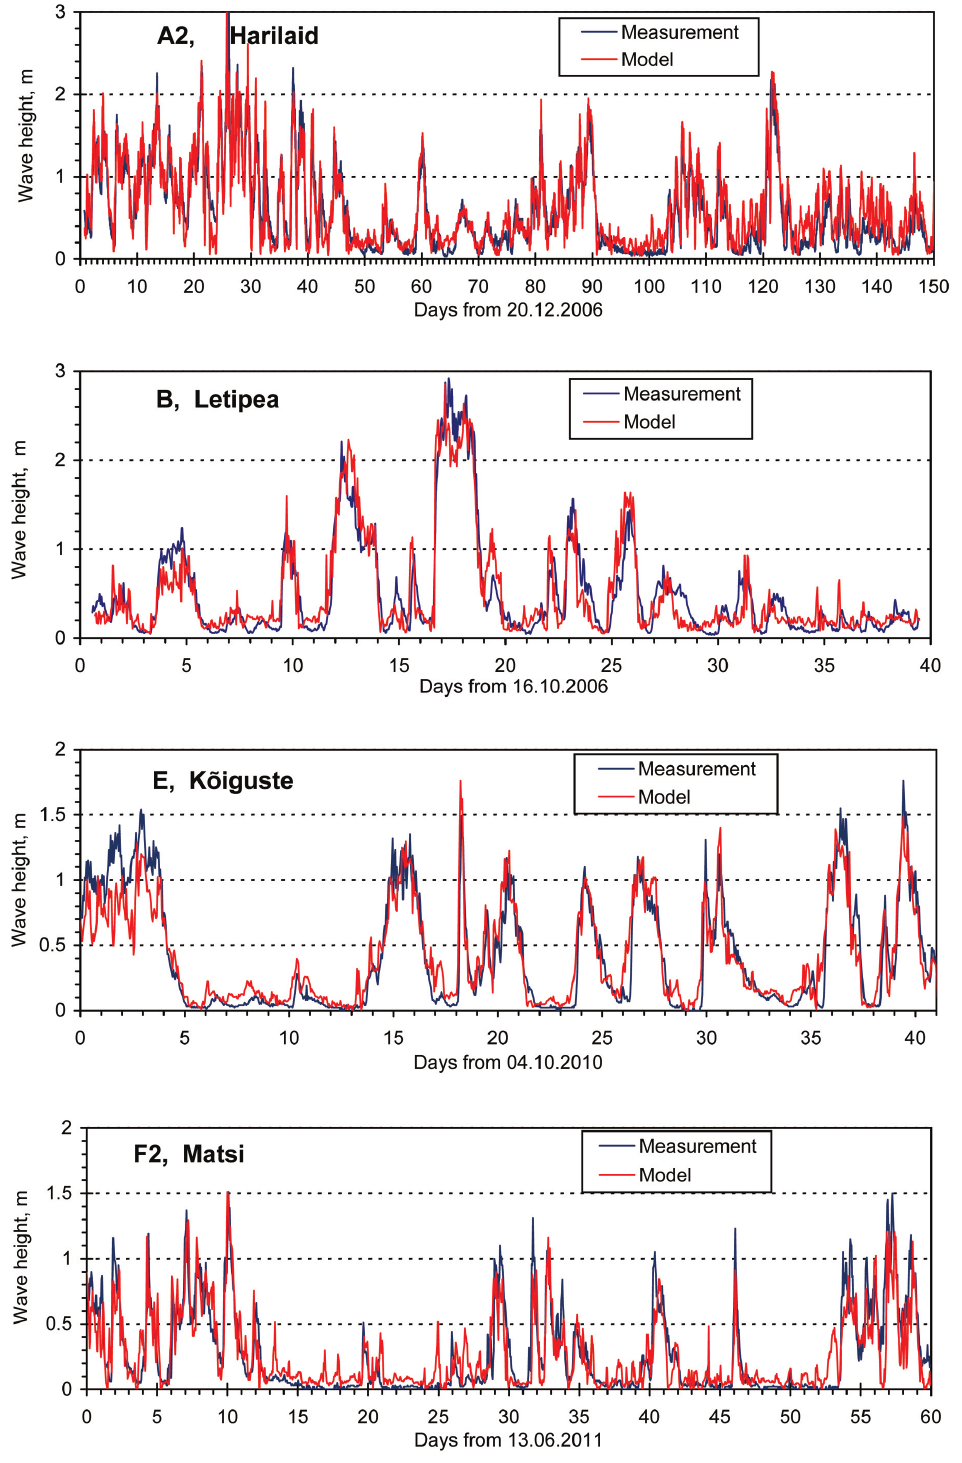
Fig. 3. Measured and modelled wave series in four calibration examples (see also Table 1 for all calibrations and additional